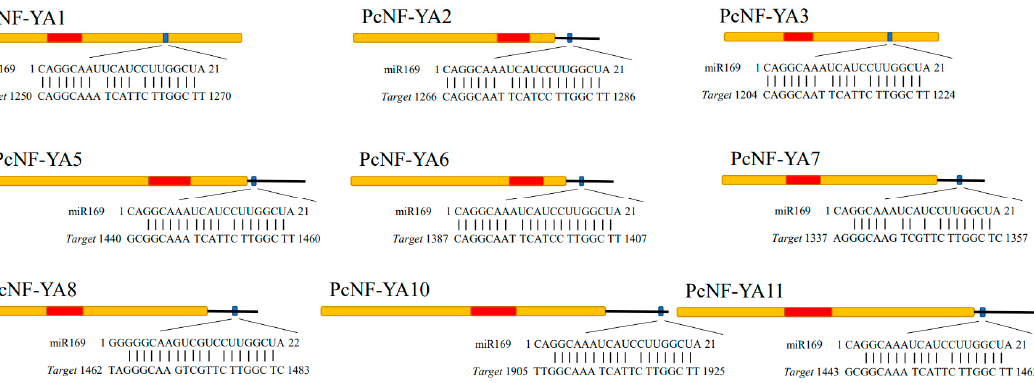
Figure 4. miR169 family members and their target site in the PcNF-YA genes. miR169 target site in the PcNF-YA1 , 2 , 3 , 5 , 6 , 7 , 8 , 10 and 11 genes. Yellow boxes represent the CDS, red boxes represent the CBF domain, and lines represent the 3 (cid:48) UTR. The miR169 target sites with the nucleotide positions of PcNF-YA transcripts are shown in blue.